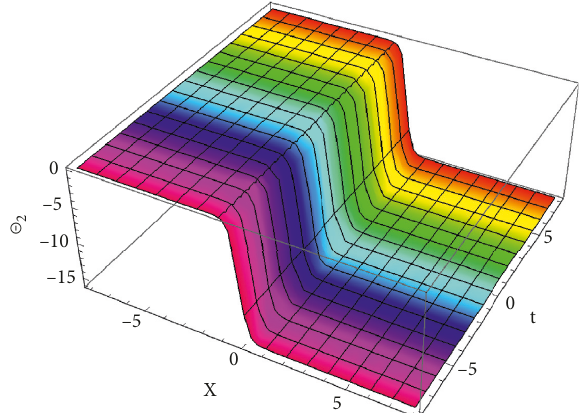
Figure 8: Plots of equations (74), for m � 0, ξ � 0 . 2, λ � 0 . 2, σ � 0 . 3, μ � 0 . 3, and w � 2. Ω 1 1 1